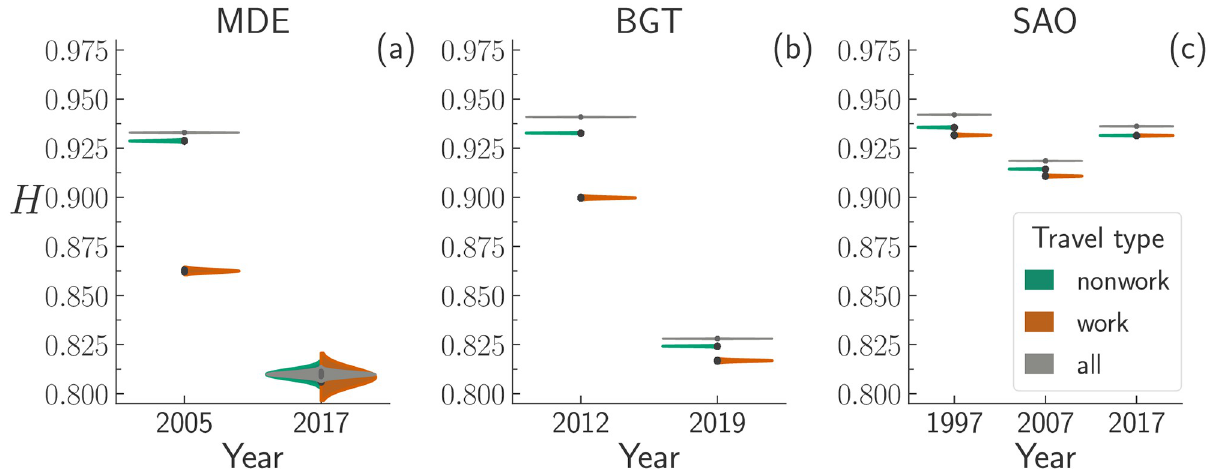
Fig 3. Violin plots of the bootstrapped mobility diversity, H , for all , work and nonwork travels made in each region and year. To better visualise the overlap (or not) between the distributions of all , work , and nonwork travels, we show the distributions for all travels duplicated (entire grey violins instead of